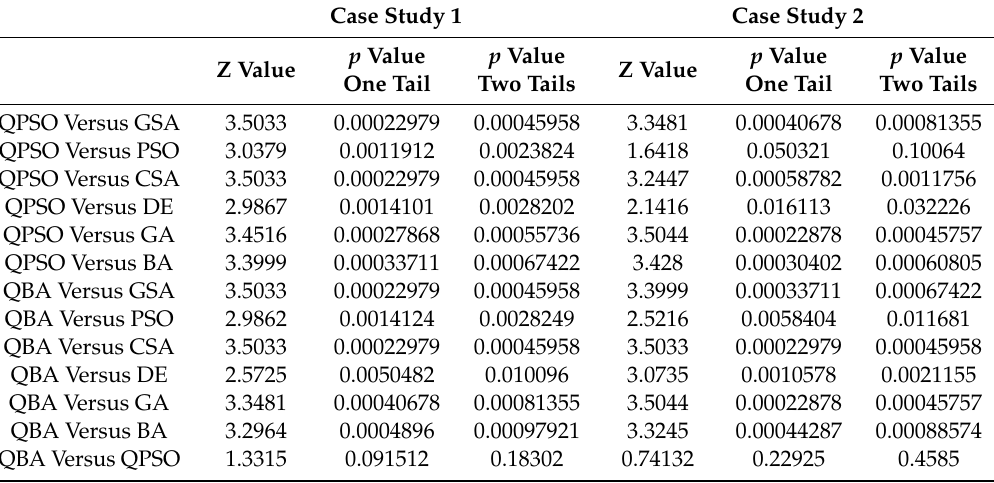
Table 6. Statistical data of applied metaheuristic algorithms on well placement optimization for case study 1 reservoir.